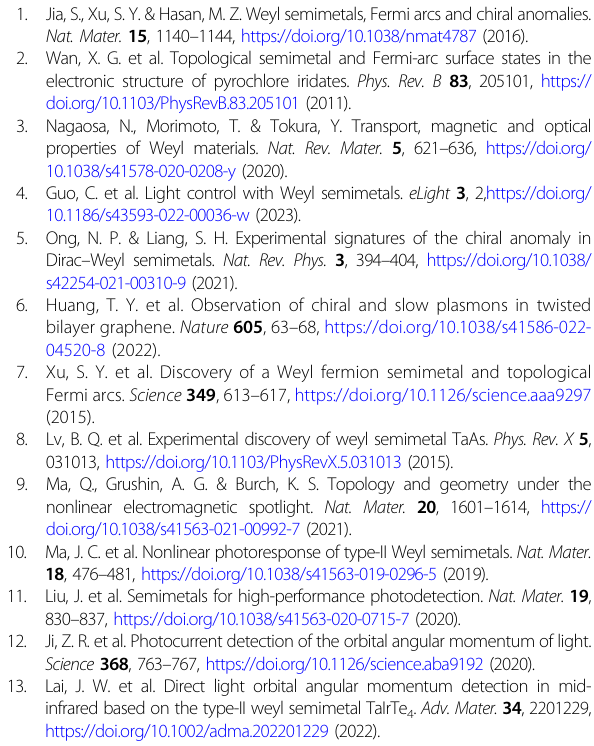
Fig. 1 Typical band structure of Weyl semimetals (left) and its nano- structured photonic